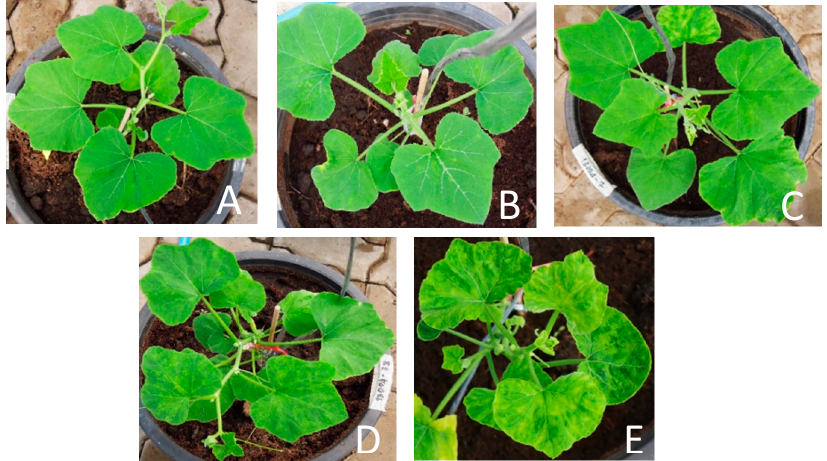
Figure 1. Symptom scoring of SLCCNV/ToLCNDV in pumpkin plants was performed according to the following scale: 0 no visible symptoms ( A ); 1 mild symptoms ( B ); 2 moderate symptoms ( C ); 3 severe symptoms ( D ) and very severe symptoms ( E ).